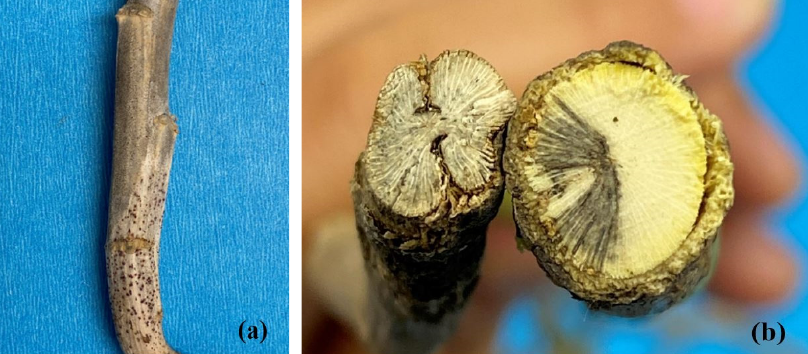
Figure 7. Pycnidia of Leptosphaeria maculans (lower portion of stem) and microsclerotia of Verticillium longisporum (upper portion) occurring on the same canola stem ( a ). Cross-sections of canola stems showing the discoloration caused by Verticillium stripe (left) and blackleg (right) ( b ).